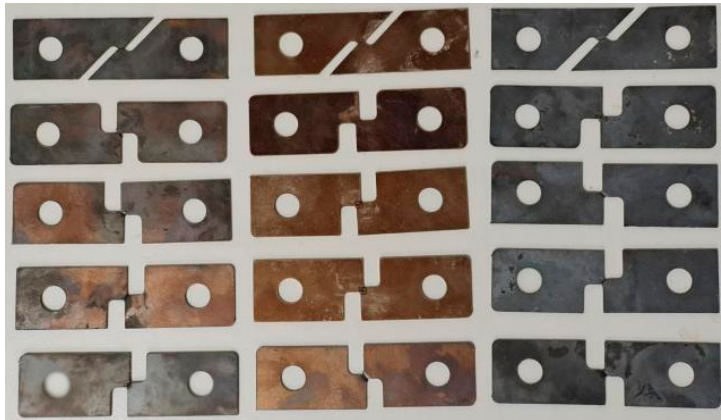
Figure 4. 0 ◦ shear specimen and other angles shear specimen ( α = 0 ◦ ,15 ◦ ,30 ◦ ,45 ◦ ,60 ◦ ) .